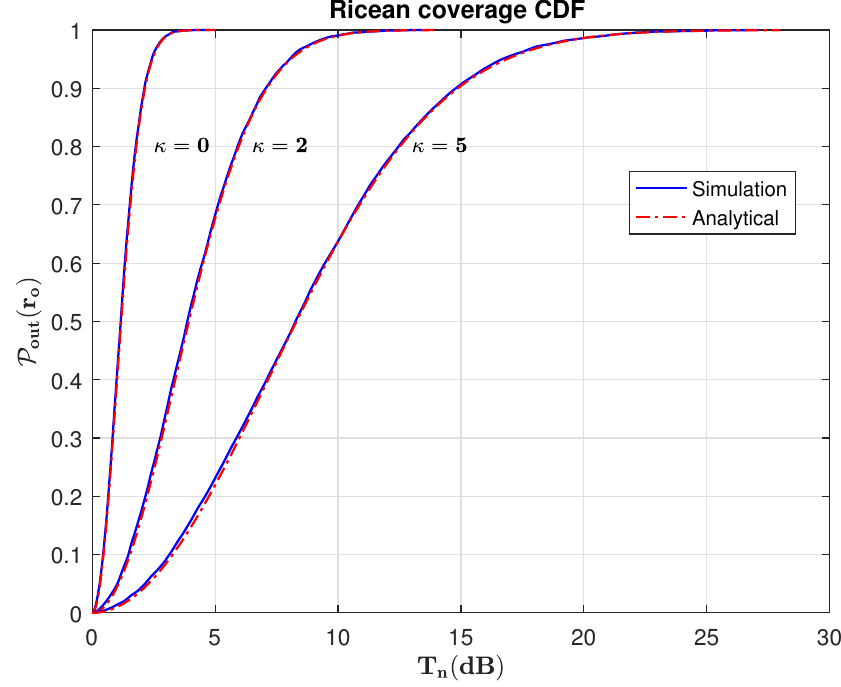
Figure 6. Plotting outage probability versus SIR comparing various cases of Ricean